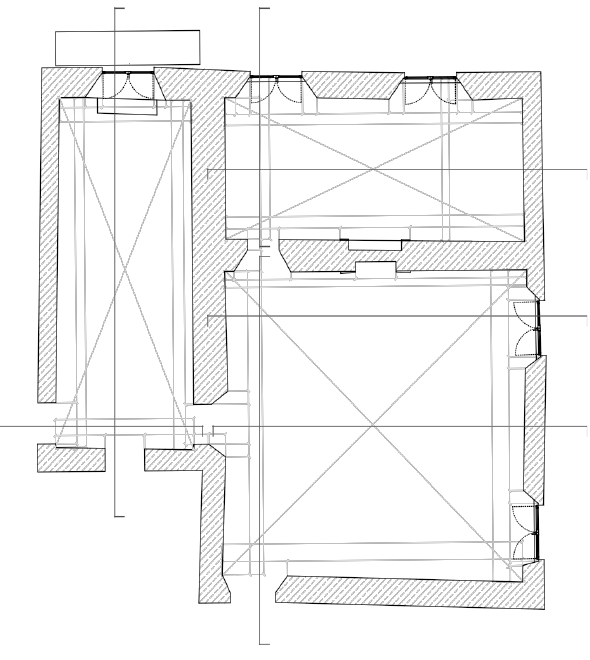
Figure 5. Surveyed plans with section signs of the 3